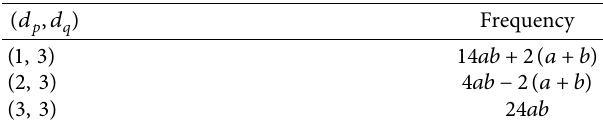
Table 1: Te edge partition of C degree of end vertices of each edge.